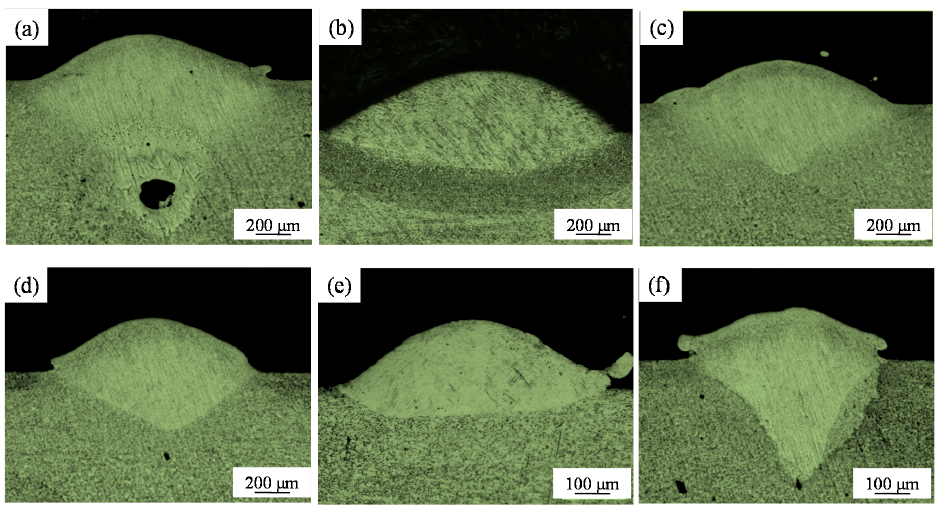
Figure 6. Optical micrographs showing the cross-sections of single-scan tracks produced with a large- diameter (200 µm) laser beam (P = 400 W, δ = 200 µm). ( a ) v = 25 mm/s; ( b ) v = 50 mm/s; ( c ) v = 75 large-diameter (200 µ m) laser beam (P = 400 W, δ = 200 µ m). ( a ) v = 25 mm/s; ( b ) v = 50 mm/s; mm/s; ( d ) v = 100 mm/s; ( e ) v = 150 mm/s; ( f ) v = 200 mm/s. ( c ) v = 75 mm/s; ( d ) v = 100 mm/s; ( e ) v = 150 mm/s; ( f ) v = 200